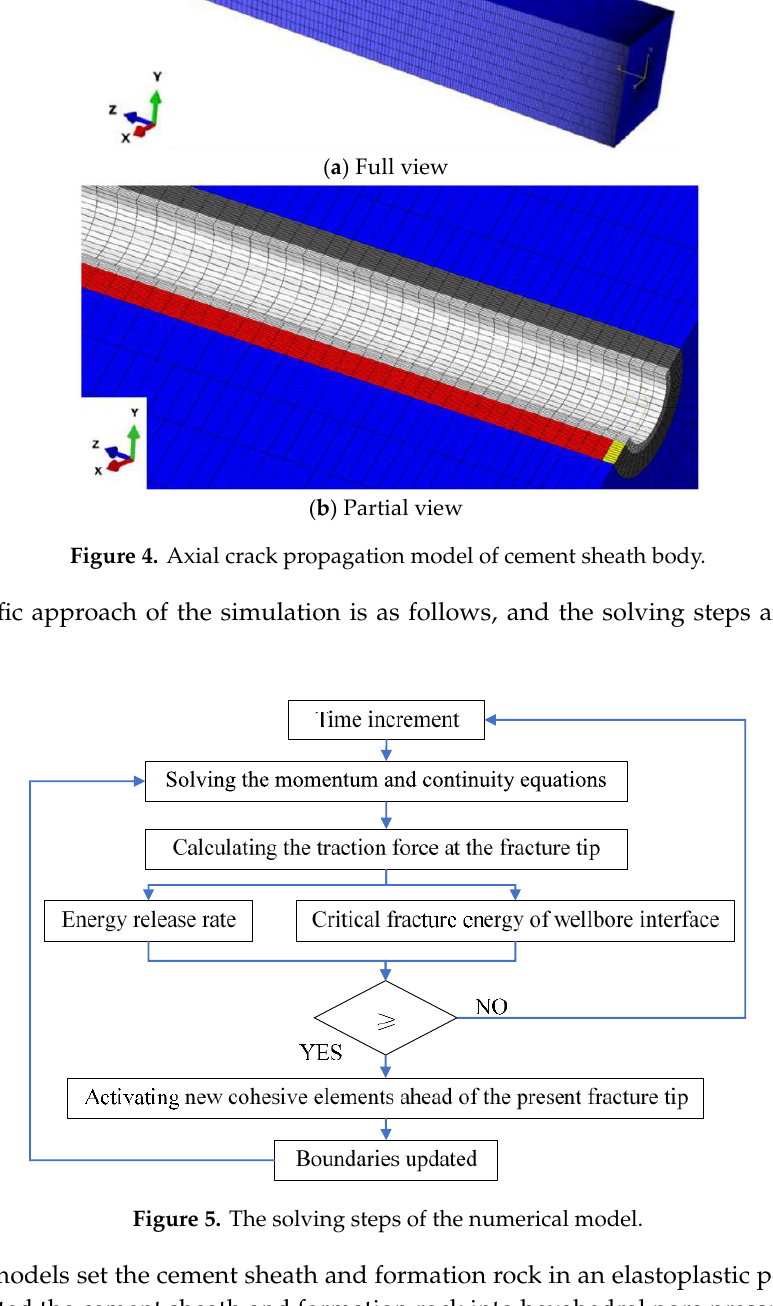
Figure 3. Circumferential crack propagation model of cement sheath body.